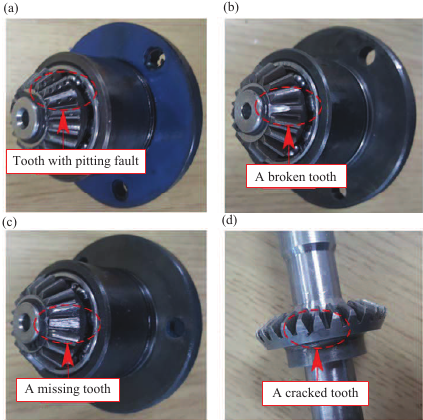
Figure 5. The designed gear faults: ( a ) Pitting in the driving tooth; ( b ) A broken tooth of driving gear; ( c ) A missing tooth of driving gear; ( d ) A cracked tooth of follower gear.